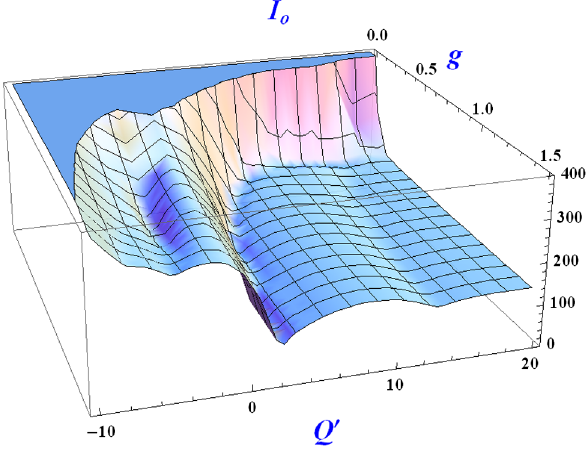
FIG. 16. Same as above, but for two 50 ns single beams at the end of the beta-squeeze